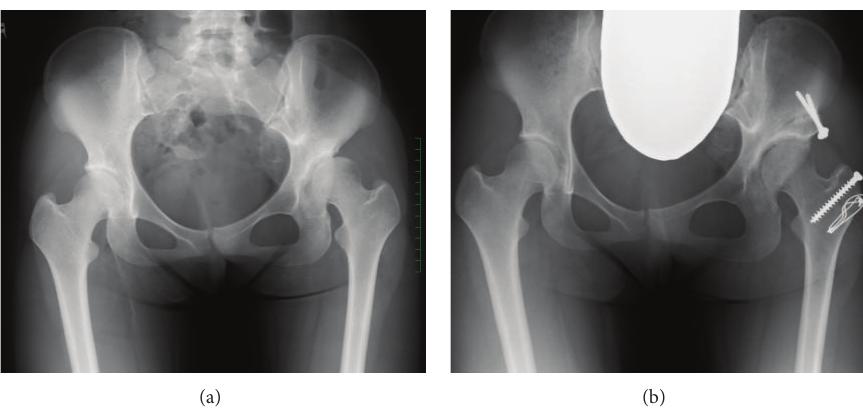
Figure1:A16-year-femalewithlefthipsubluxationassociatedwithacetabulardysplasiaandpartialsacralagenesistreatedwithperiacetabular osteotomy combined with allogeneic bone grafting. (a) Preoperative AP radiograph of the pelvis. (b) An AP radiograph obtained two years after the operation. The patient had achieved anatomical correction with an adequate bone stock in the hip